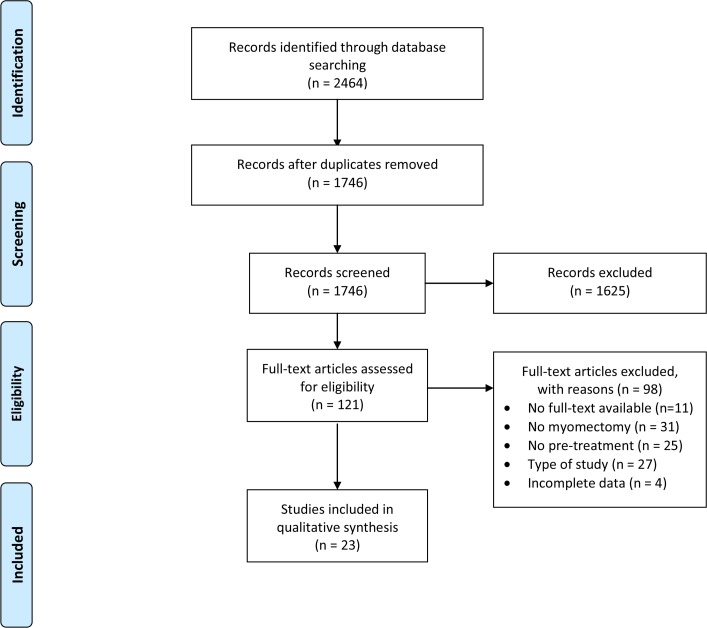
PRISMA Flow diagram.PRISMA (Preferred Reporting Items for Systematic Reviews and Meta-Analyses) flow diagram of study selection.